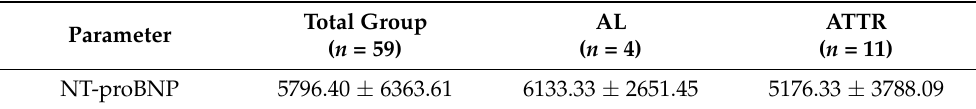
Table 14. Statistical representation of NT-proBNP levels for ATTR and AL positive patients. Total Group Parameter